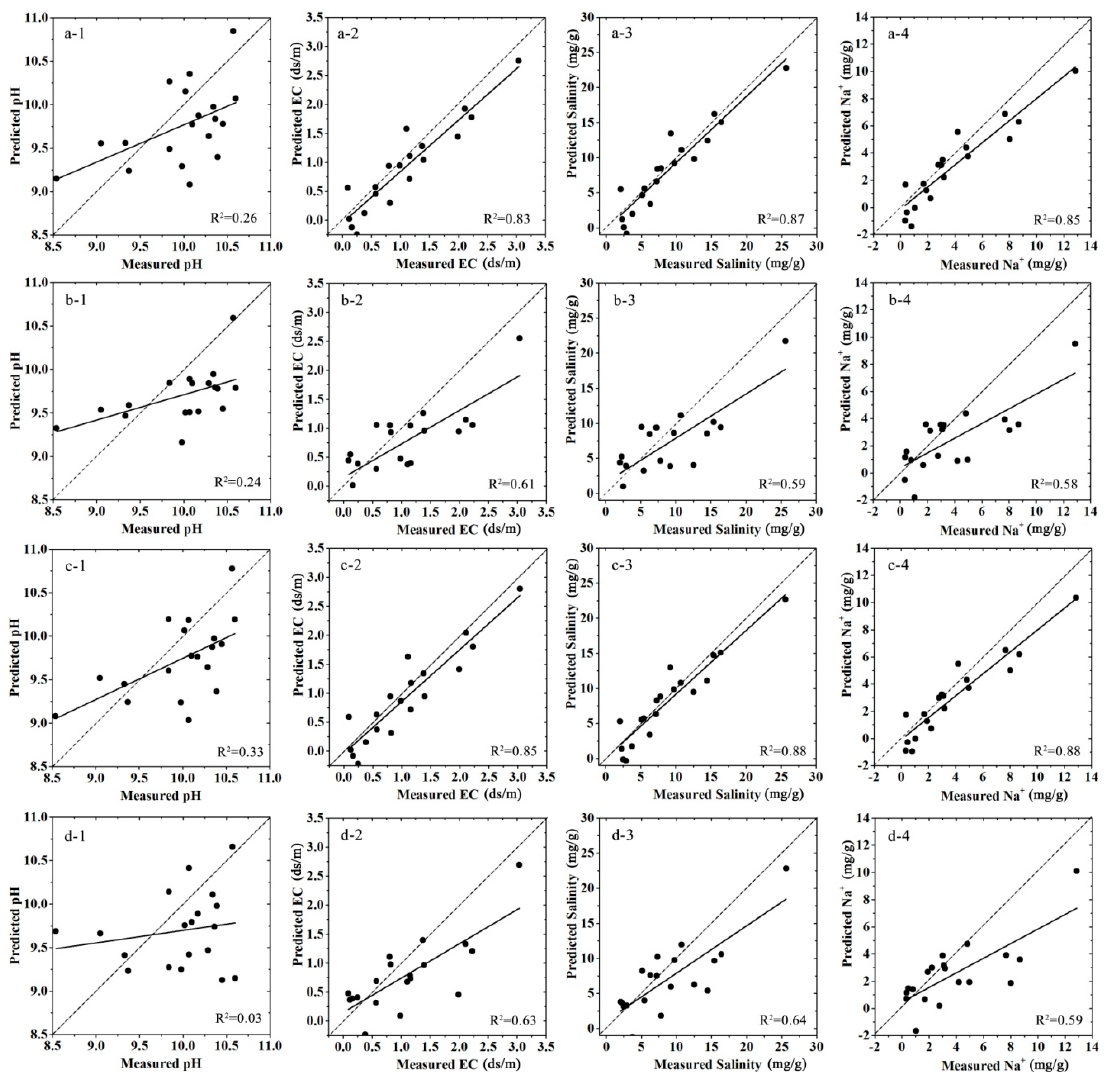
Figure 7. Fitting results of the predicted soil properties against the measured properties. ( a ) Univariate models based on mixed reflectance calculated from the block soil samples, ( b ) univariate models based on mixed reflectance calculated from the comparison soil samples, ( c ) multivariate models based on mixed reflectance of the block soil samples, ( d ) multivariate models based on mixed reflectance of the comparison soil samples.